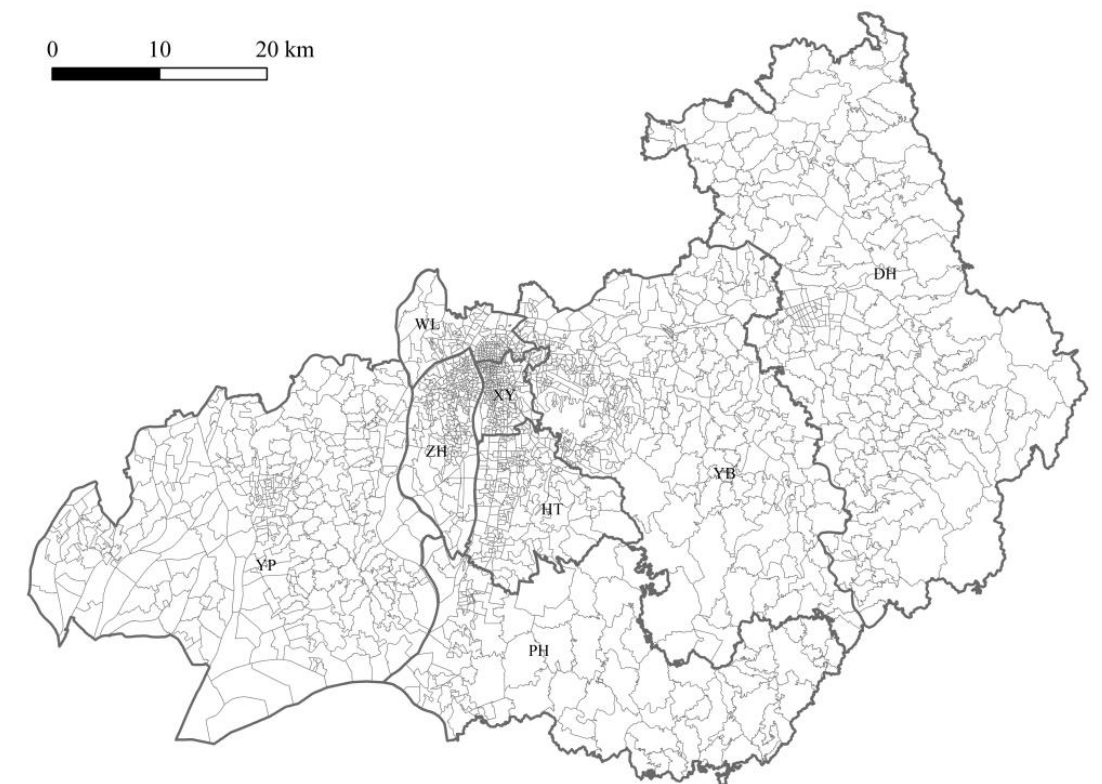
Figure 1. Schematic diagram of the study area, ZG City.